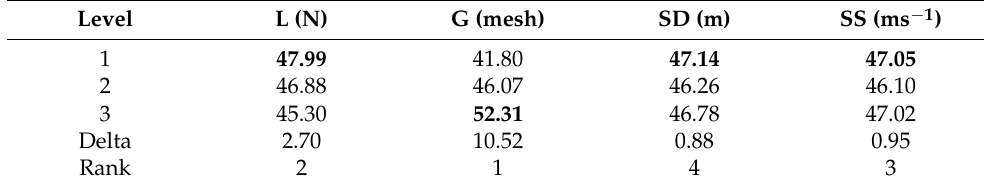
Figure 10. Main effect plot for mean T s of PTFE matrix composites.